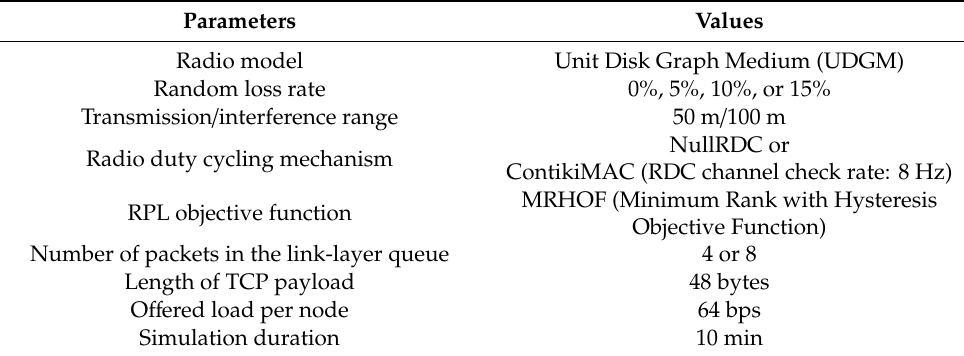
Figure 1. Network configuration for simulation. Table 1. Simulation parameters.